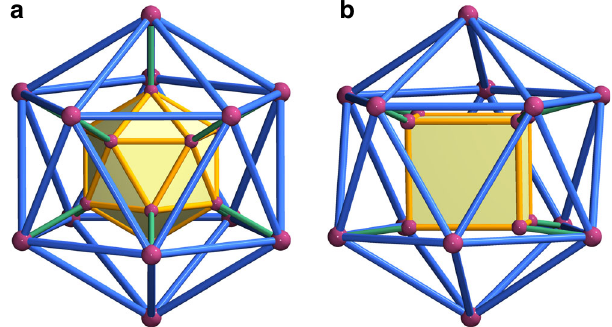
Fig. 1 Two known endohedral models. The inner (marked in orange) and outer (marked in blue) cages of different sizes, whether they have the same ( a ) or different ( b ) geometry, are interconnected by covalent linkages (marked in